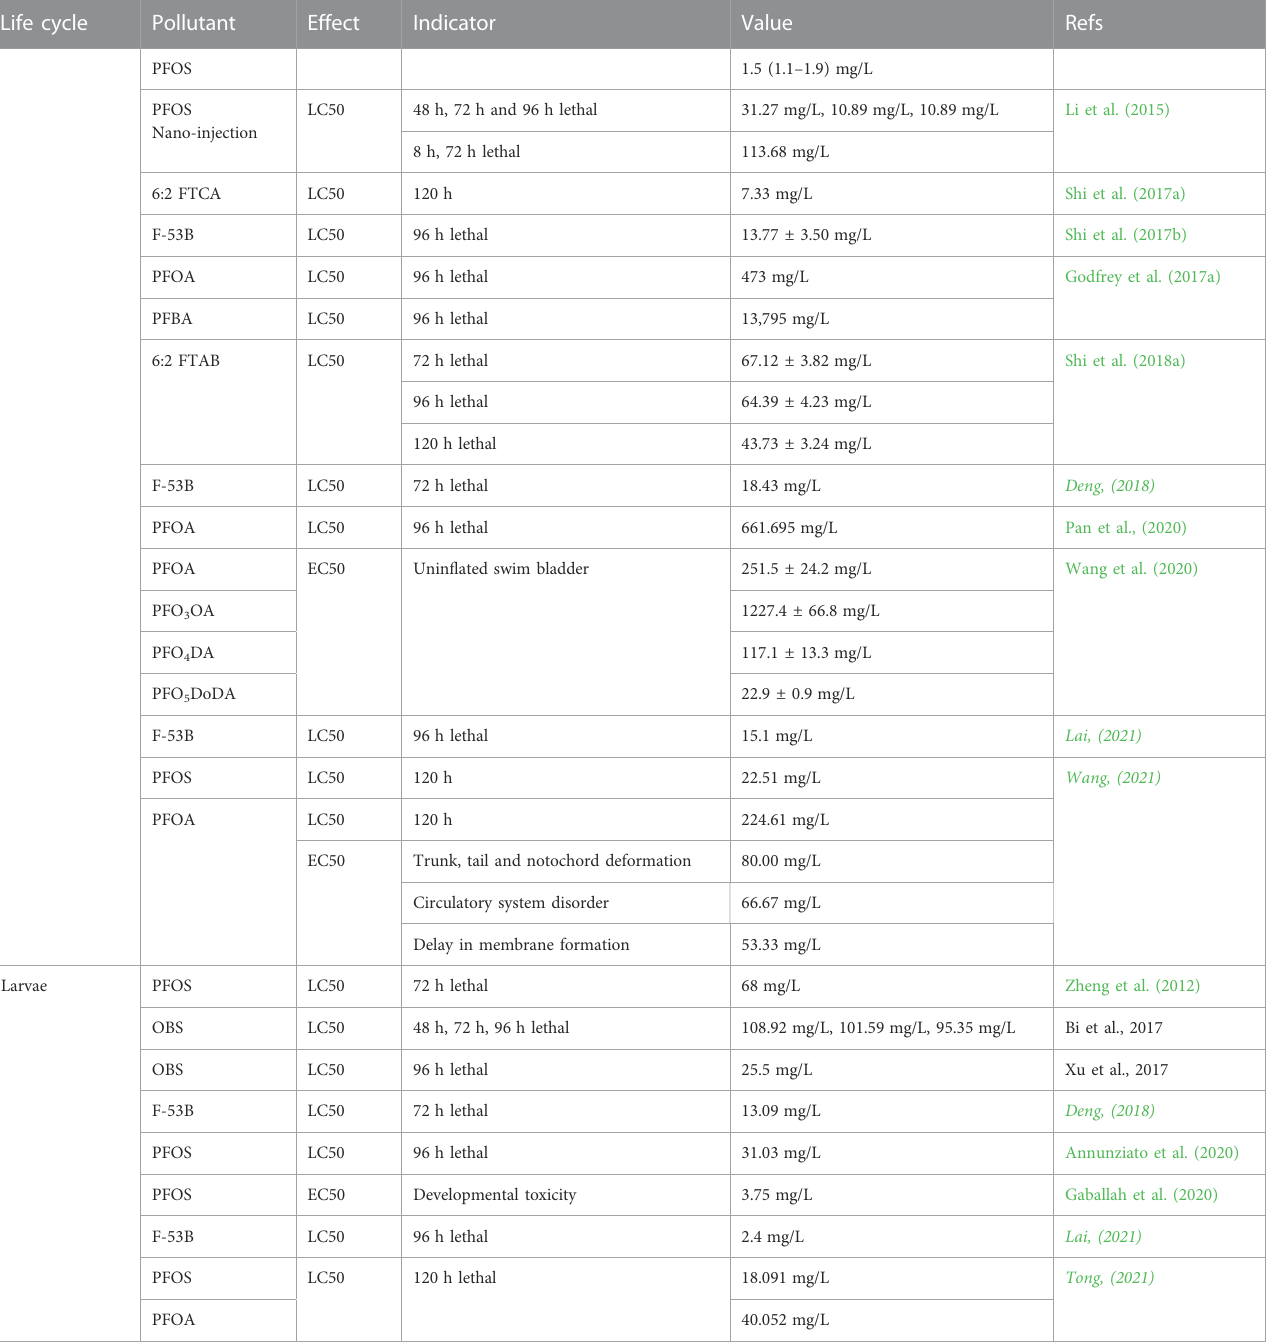
TABLE 1 ( Continued ) EC50/LC50 values of target PFASs and some substitutes on zebra fi